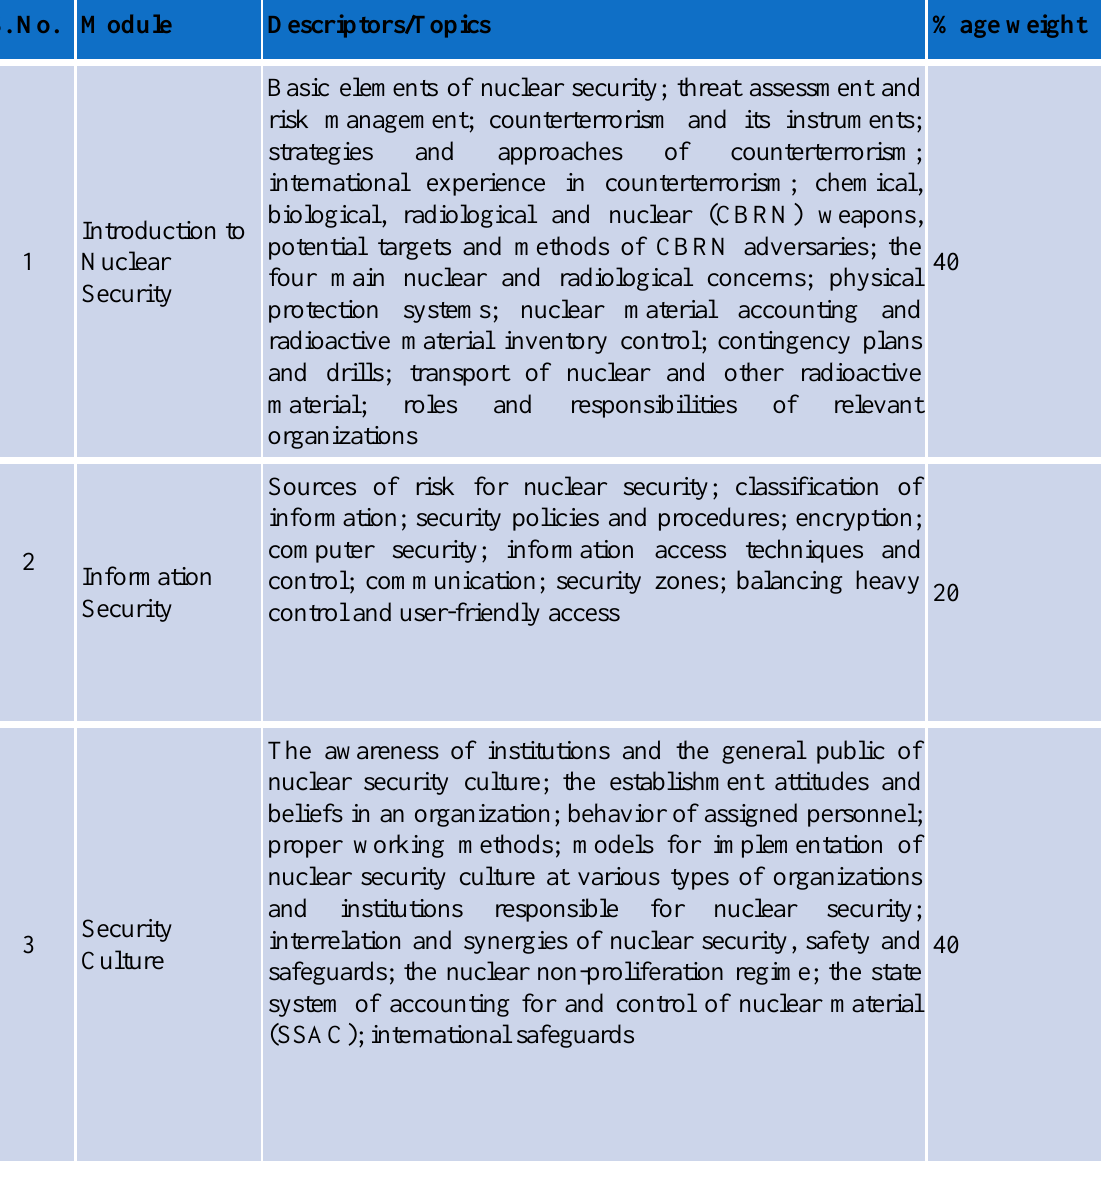
Table 2: Outline of the Postgraduate-level Course, “Nuclear Security and Security Culture” S. No.